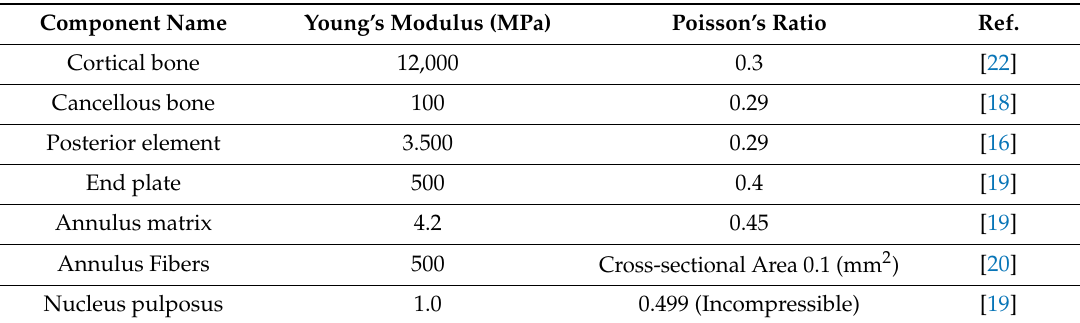
Table 1. Peak stress levels of motion in the motion model.